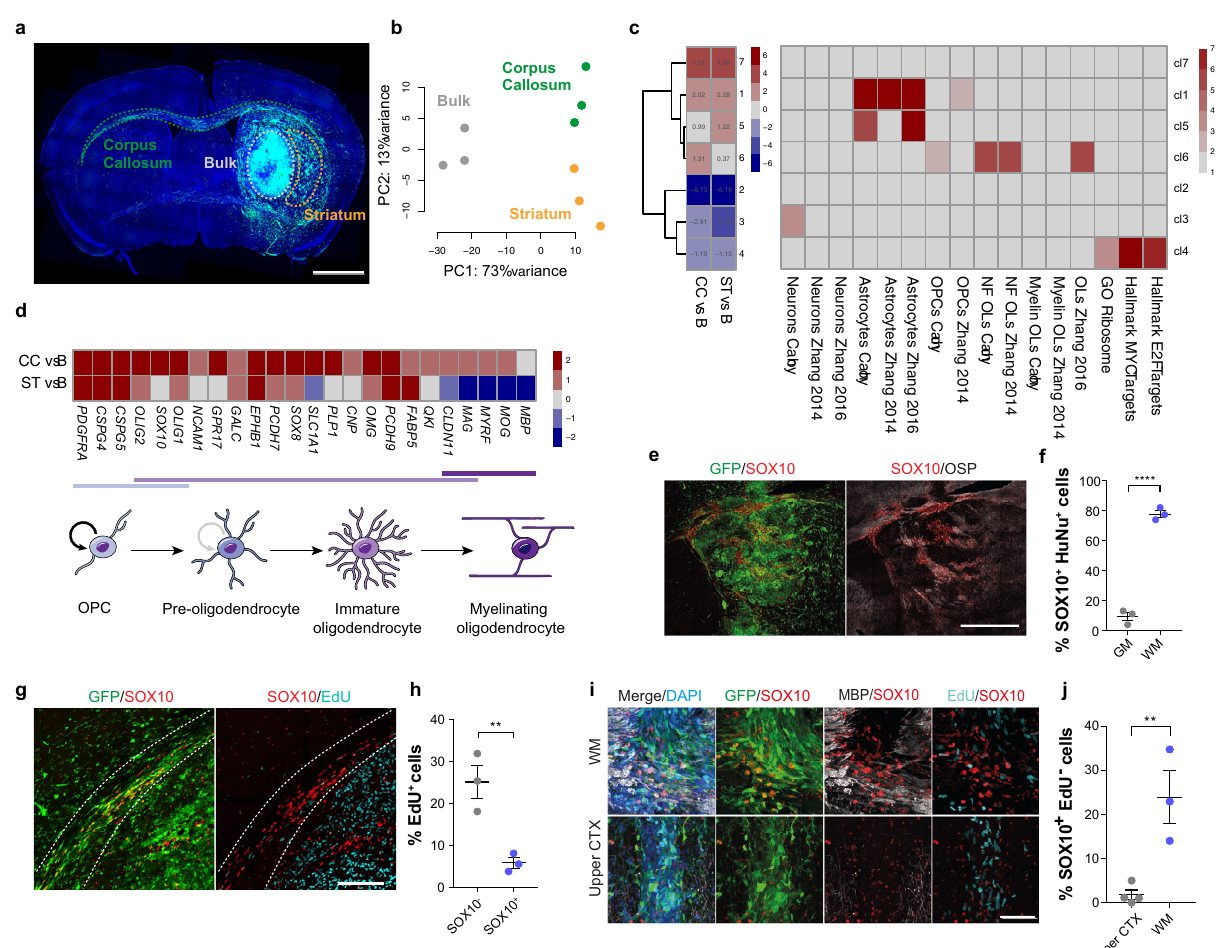
Fig. 1 GBM cells invading into white matter acquire pre-oligodendrocyte fate. a representative fl uorescence image of a G144 xenograft (PDX144) collected for region-speci fi c RNA-seq. Brain regions microdissected for FACS puri fi cation of GFP + cells are shown, nuclei are counterstained with DAPI (blue). Scale = 1 mm. b PCA plot of rlog-normalised DESeq2 expression scores for the resulting RNA-seq libraries. n = 3 xenografts. c left panel: K-means clustering of DESeq2 expression ratios (absolute log 2 expression ratio > 0.58, p adjust < 0.05) for tumour cells invading into the corpus callosum (CC) or striatum (ST) relative to the tumour bulk. One sided Fisher exact test with Bonferroni multiple comparisons test. B Right panel: overlap of K-means cluster with gene signatures for oligodendrocyte progenitor cell (OPC), Oligodendrocytic, Astrocytic and Neuronal lineages as well as proliferation signatures. Colours represent -log 10 of enrichment adjusted p-values. d top: DESeq2 log 2 expression ratios of markers of the oligodendrocyte lineage organised by differentiation stage in tumour cells from CC and ST relative to B. bottom: schematic illustration of the maturation of oligodendrocyte lineage cells. e representative immuno fl uorescence staining for SOX10 (red) and the myelin marker oligodendrocyte-speci fi c protein (OSP, grey) of GFP-labelled PDX144 tumours (green). Scale = 1 mm. f quanti fi cation of percentage of SOX10 + tumour cells in grey (GM) and white matter (WM). ≥ 750 cells per xenograft were counted. Mean± SEM, n = 3 xenografts p = 0.000047. Unpaired two-tailed Student ’ s t test. g representative EdU (turquoise) and SOX10 (red) staining and h quanti fi cation of actively proliferating SOX10 + and SOX10 − GFP + tumour cells in the corpus callosum. Scale = 500 µ m. ≥ 1000 cells per xenograft were counted. Mean ± SEM, n = 3 xenografts. p = 0.01, unpaired two-tailed Student ’ s t test. i representative SOX10 + (red)/EdU − (Turquoise) immuno fl uorescence staining and j quanti fi cation of GFP + tumour cells implanted in the white matter of the corpus callosum (top) or the grey matter of the upper cortex (bottom). ≥ 140 cells per xenograft were counted. Scale = 100 µ m, Mean± SEM, n = 3 xenografts p = 0.008. Unpaired two- tailed Student ’ s t test. SOX10 induction, displaying homogeneous high SOX10 expres- that a subset of patient tumours (~18%) expressed high levels of sion throughout the xenograft and was not analysed further. In SOX10 . SOX10 high tumours were enriched for the proneural, but contrast, the other four lines were similar to G144 cells, with a also included mesenchymal and classical transcriptional subtypes, somewhat variable, but consistent increase in the proportion of as well as IDH1 mutant tumours, suggesting that pre- SOX10 + cells in white matter as compared to grey matter (Fig. 2a, oligodendrocyte differentiation may occur across all GBMs b and Supplementary Fig. 2d). In addition, as in G144 xenografts, (Supplementary Fig. 2a, b) 9 . In addition, a subset of primary GSC lines retained above average SOX10 expression in vitro, SOX10 + cells proliferated signi fi cantly less than SOX10 − cells in white matter and partially progressed to CNP + or CC1 + con fi rming cell-intrinsic expression in tumour cells (Supplemen- immature pre-oligodendrocyte cells (Fig. 2c and Supplementary tary Fig. 2c and Supplementary Table 2). We next xenotrans- Fig. 1k, l and Fig. 2e). To determine whether the white matter- planted fi ve SOX10 + GSC lines (three of which were freshly induced response also occurs in primary patient tumours, we took dissociated from primary tumours) and examined their behaviour two complementary approaches. First, we selected three SOX10 + in white matter. One line had lost white matter regulation of NATURE COMMUNICATIONS| (2021) 12:2184